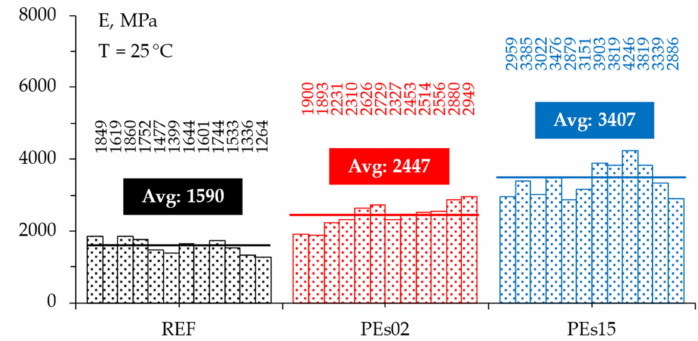
Figure 13. The stiffness modulus determined through the IT-CY tests.